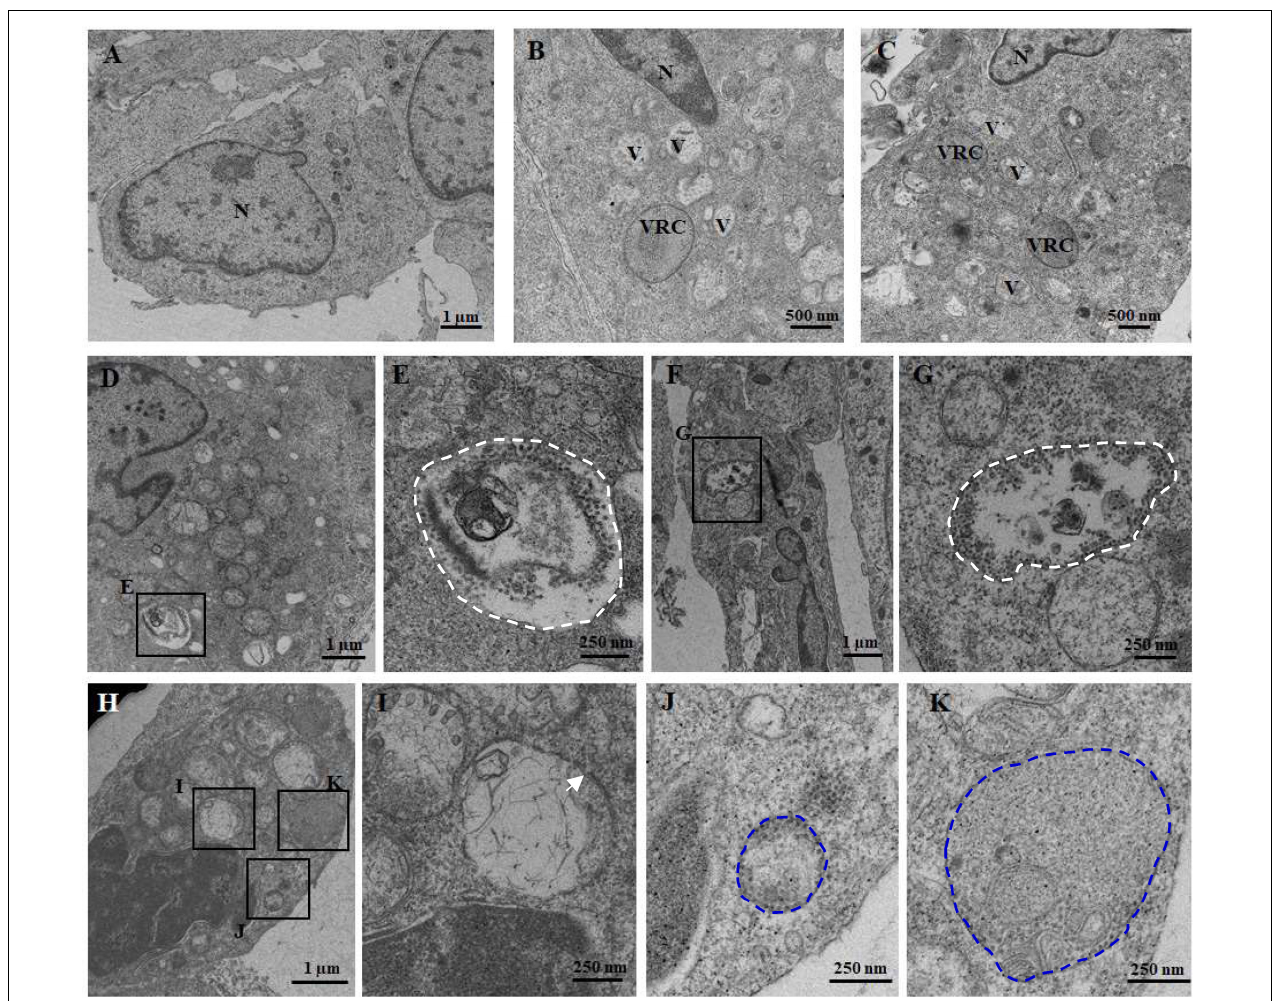
FIGURE 2 | The ultrastructure of the vacuoles in mock (A) and RGNNV-infected cells (B–K) . (A) A normal nucleus, but not vacuoles, were observed in the mock-infected cells. (B, C) A condensed nucleus and numerous vacuoles were observed in the RGNNV-infected cells. “V” indicates vacuoles and “VRC” shows the virus replication center. (D–G) The white dotted circles show the vacuoles containing cell debris and viral particles. (H–K) The blue dotted circles show the monolayer membrane structures containing viruses, and the white arrows show the vacuoles with double-membrane